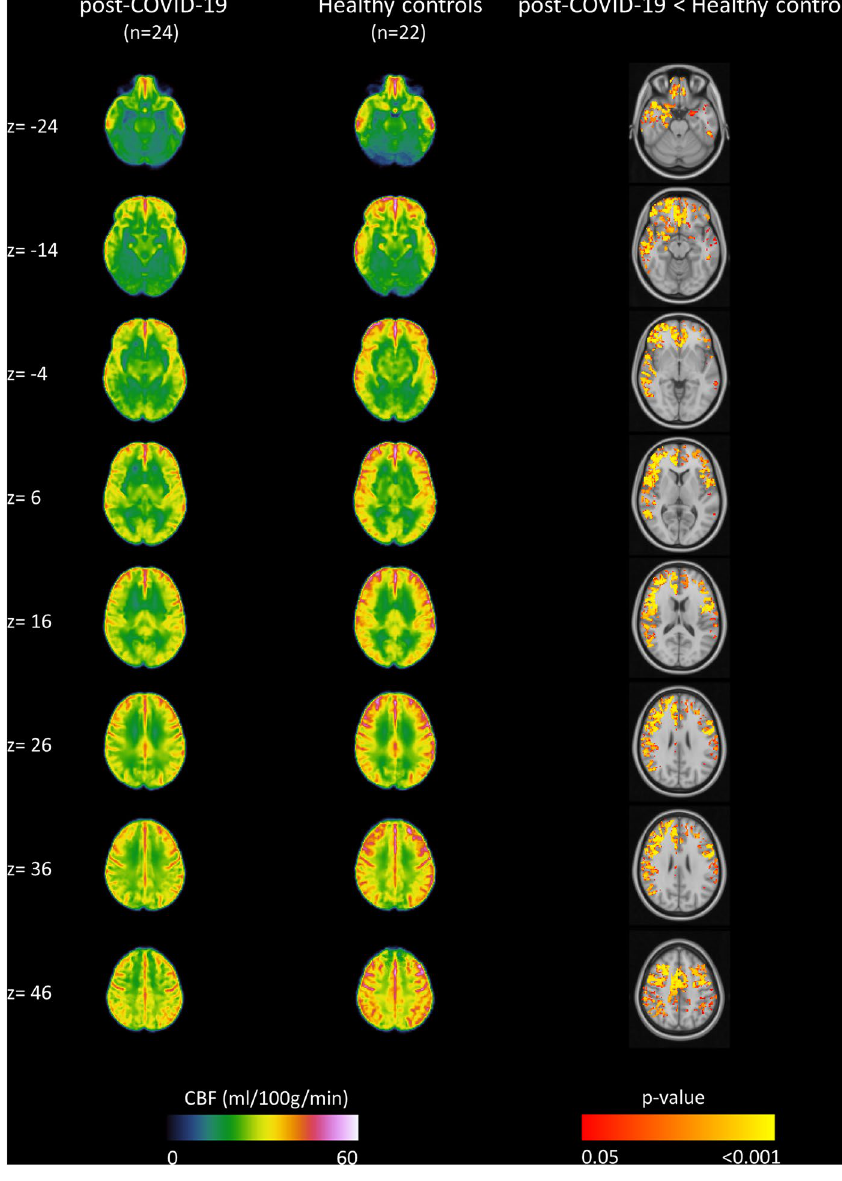
in the post-COVID-19 group compared to healthy subjects was detected in the right and left frontal, parietal and temporal cortex. The hypoperfusion areas identified in the right hemisphere regions were more extensive. No regions with a significantly higher perfusion in post-COVID-19 patients compared to healthy controls were detected. The global mean of CBF in gray matter was lower in post-COVID group compared to controls (37.7 (33.3–44.8) vs 44.6 (40.8–48.7), p-value = 0.011). Table 4 reports the results of the ROI analysis of the selected anatomical regions. The mean CBF was significantly lower in left frontal, right frontal, right parietal, left temporal and right temporal lobes in post COVID-19 compared to healthy controls. No significant differences in regional mean CBF were observed for left parietal lobe, left and right occipital lobes, as well as for cerebellum. There was no significant correlation between the MoCA scores and CBF values within the post-COVID-19 group.